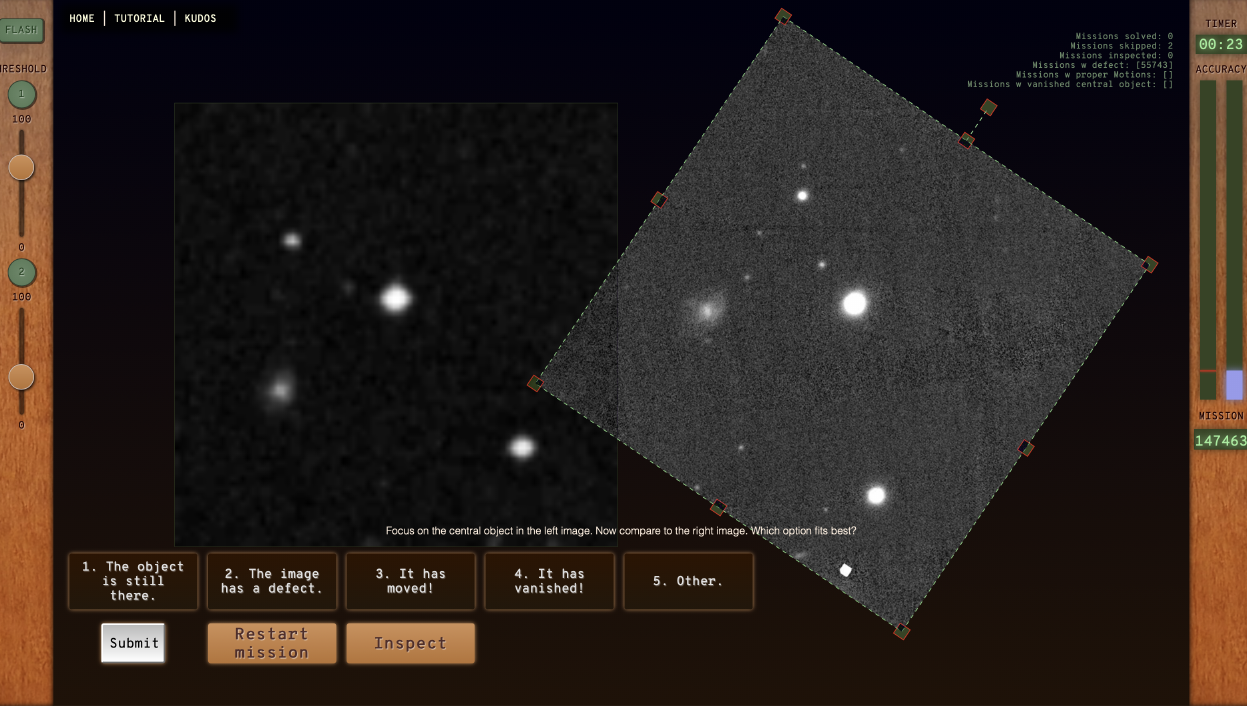
Figure 4. The main active window. Here, we see two images that have been slightly rotated relative to each other. The user can change the size of the right image, rotate it, and turn it around. The user can also blink the images by pressing the “FLASH” button in the upper left part of the